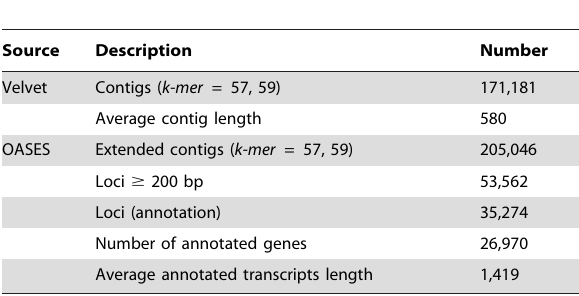
Table 3. Results of the cabbage de novo assembly using Velvet and Oases.